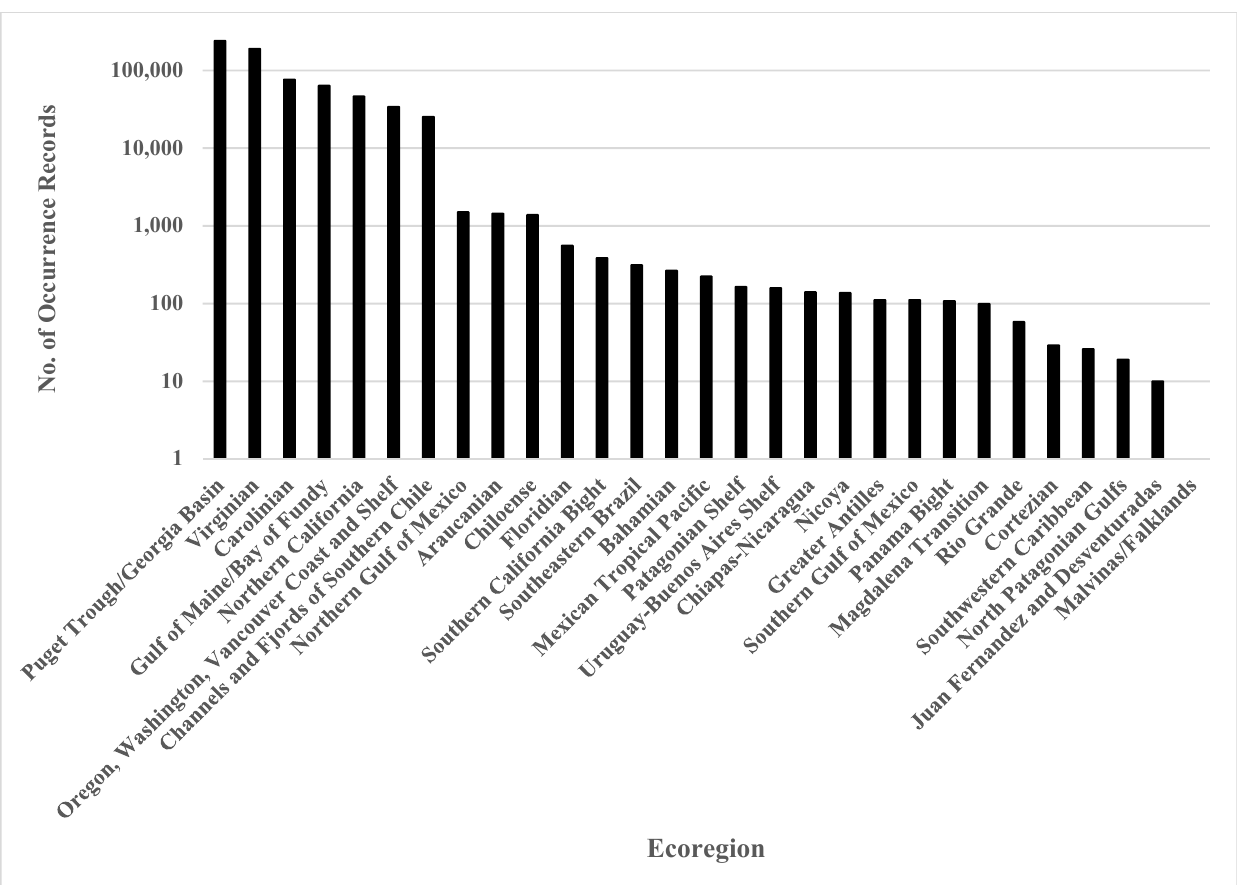
Figure 1. Relevant marine ecoregions of the Americas (based on [14]) used to evaluate sea- and shorebird records found in OBIS ([7]; accessed 7 August 2019). OBIS records found are noted by blue dots, and all marine ecoregions and occurrence records are located off the coast. Marine ecore- gions where no seabird records were found in OBIS are not shown. Dashed line along western Cen- tral America and across to the Caribbean Sea indicate that observations were recorded along a cruise track [18,19].